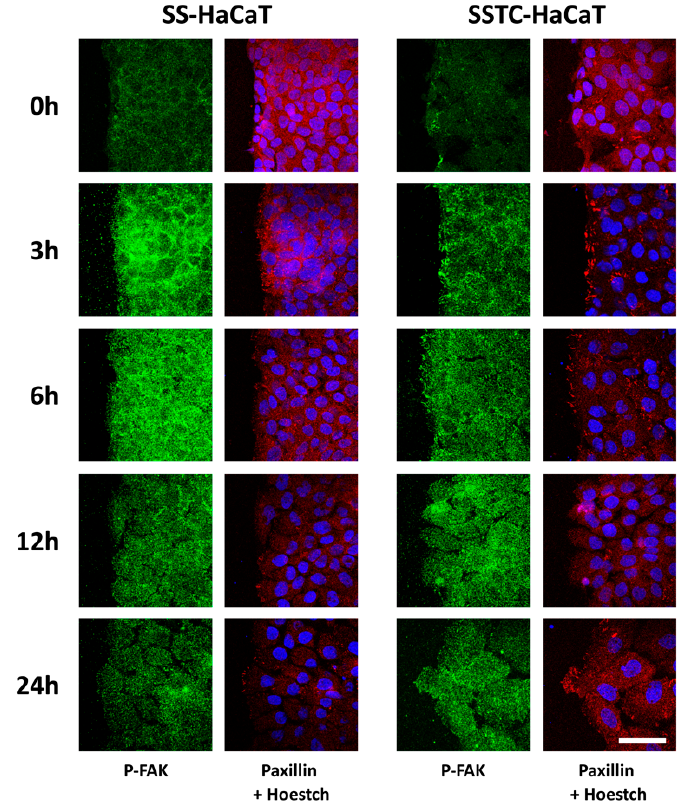
Figure 2. HaCaT cells persistently exposed to TGF- β showed altered FA dynamics. Distinct spatial and temporal patterns for the structural protein paxillin (red) and the activated modulator factor FAK (green) are shown in both SS-HaCaT and SSTC-HaCaT cells. Nuclei are colored in blue. Representative images of at least three independent experiments are shown. The scale bar equals 50 µ